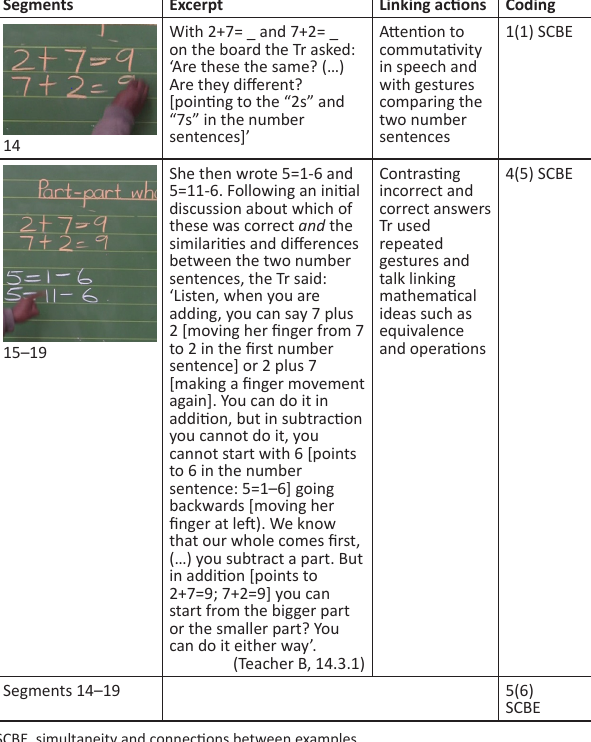
FIGURE 2: Commutativity reasoning in teaching, 2014.